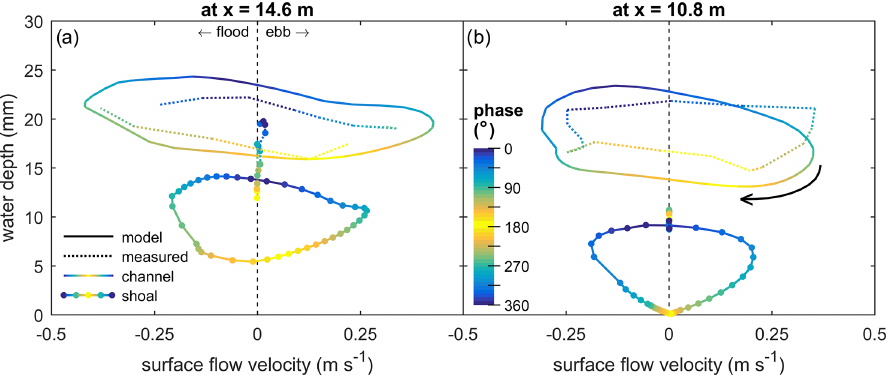
Figure 8. Tidal stage diagrams showing water depth versus surface flow velocity for a channel and shoal at (a) x = 14 . 6m and (b) x = 10 . 8m in Fig. 6a. Water depth and surface flow velocity were averaged for a 5 × 5 cell window. Colours indicate the phase in the tidal cycle.